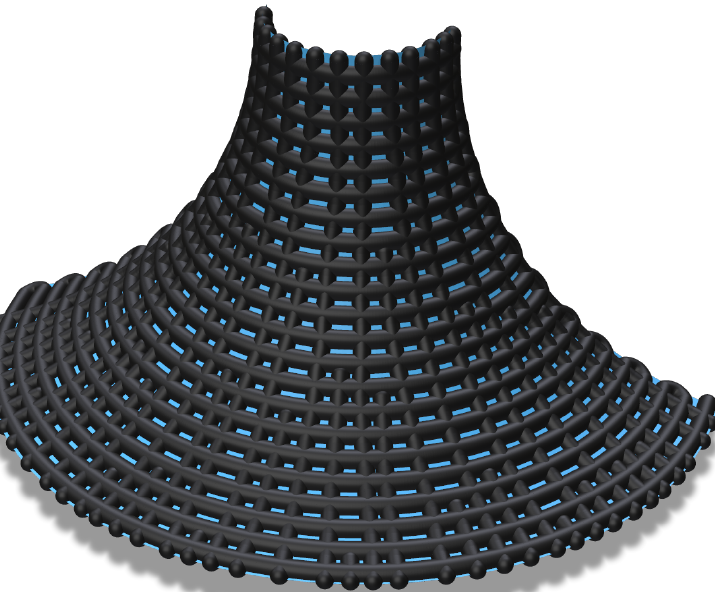
Figure 3. A grid-like structure in the spirit of draped carbon fiber fabric resulting from layering paths generated by the Ortheo and FInA algorithms. This result is unachievable with classical methods such as tape-laying or hand layup. Filament thickness displayed does not correspond to thickness when